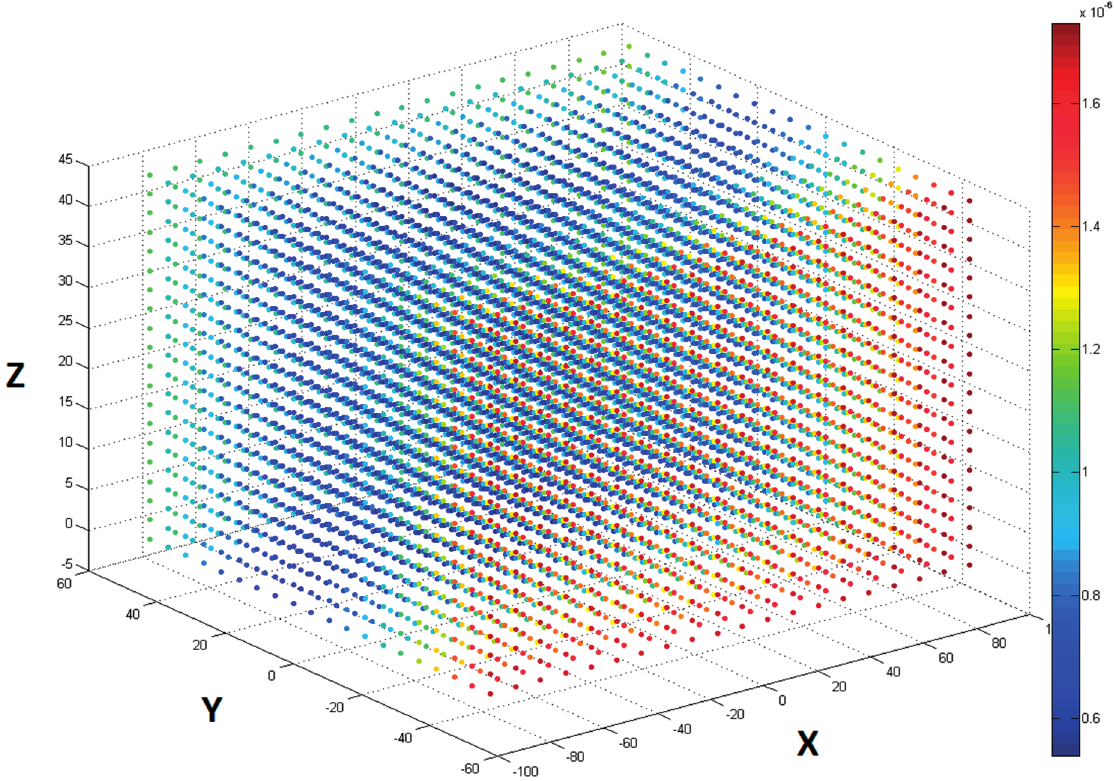
Figure 9. Calibration errors on a uniformly sampled grid in Leap Motion Controller space after projecting to display